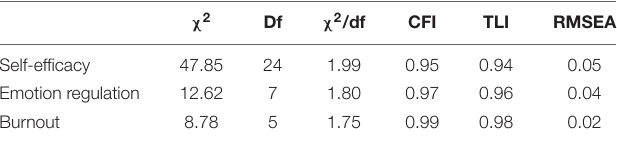
TABLE 1 | Measurement model of the latent variables.